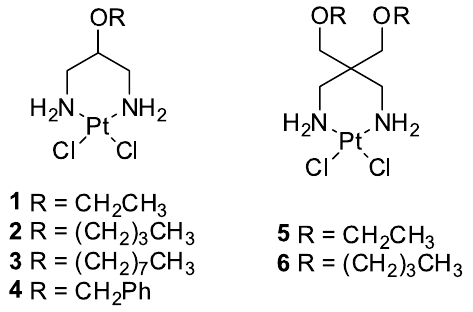
FIGURE 1 - Structure of the platinum complexes